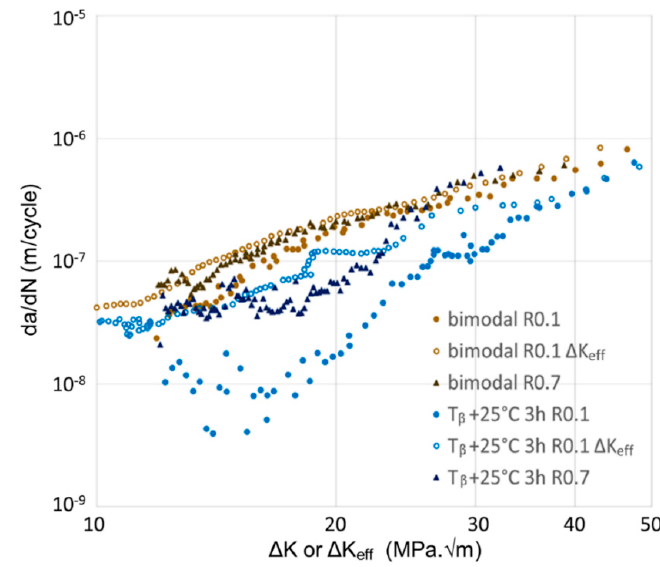
Figure 14. Fatigue crack propagation rates as a function of effective stress intensity range Δ K eff at R = 0.1 and R = 0.7 tests of the bimodal microstructure and one lamellar microstructure.